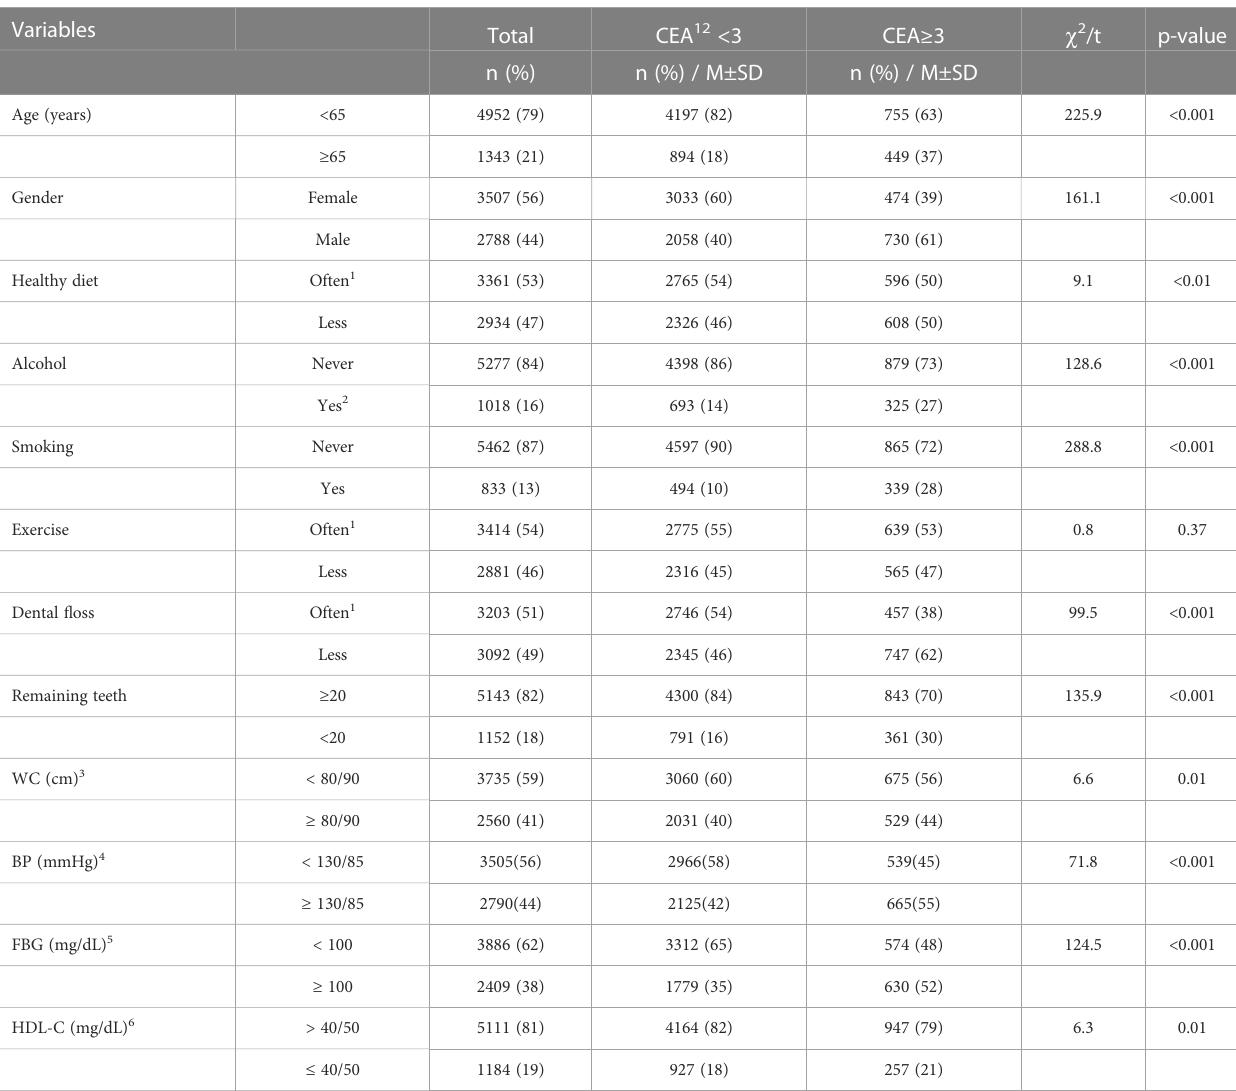
TABLE 1 Univariate analysis of factors associated with higher serum level of CEA (N=6295).